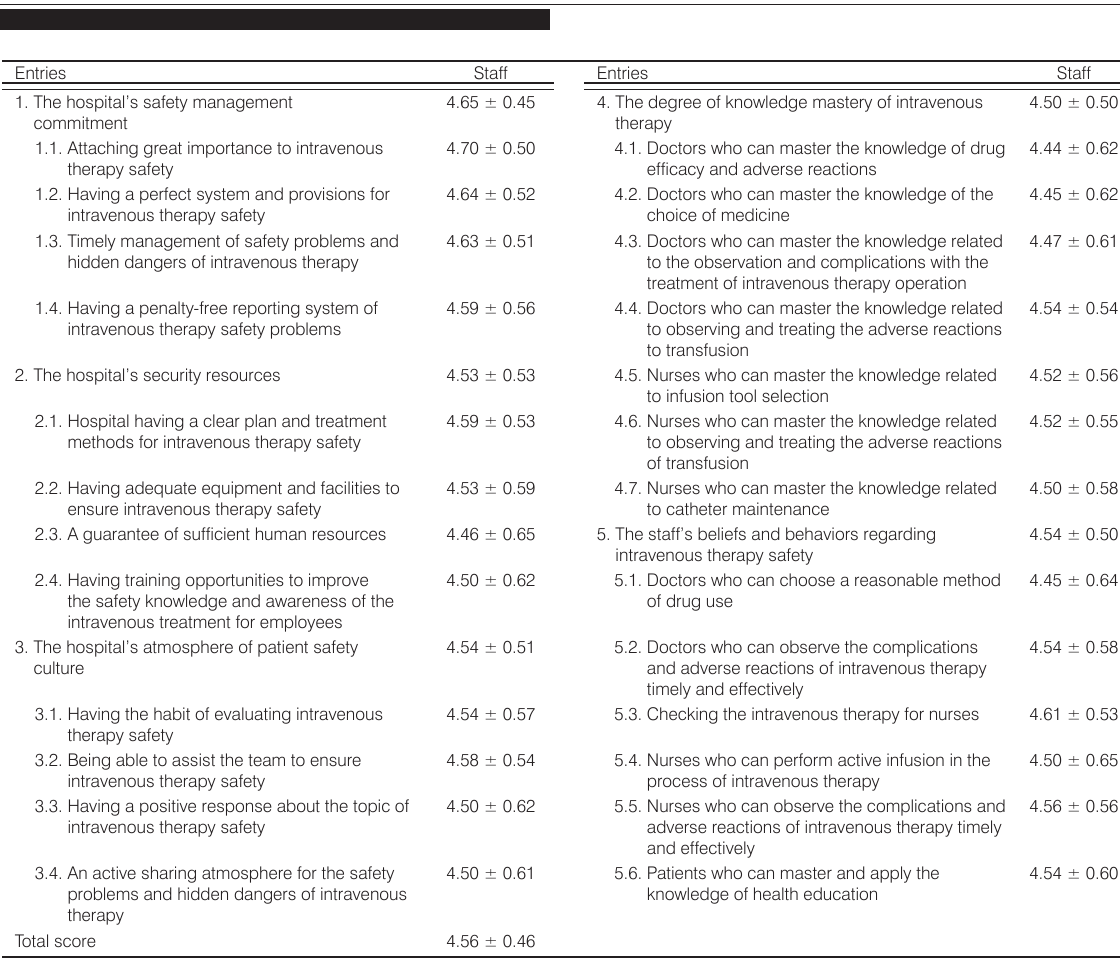
Table 1. The total and entry scores of the patient safety culture regarding intravenous therapy ( M ±SD) ( N =333).